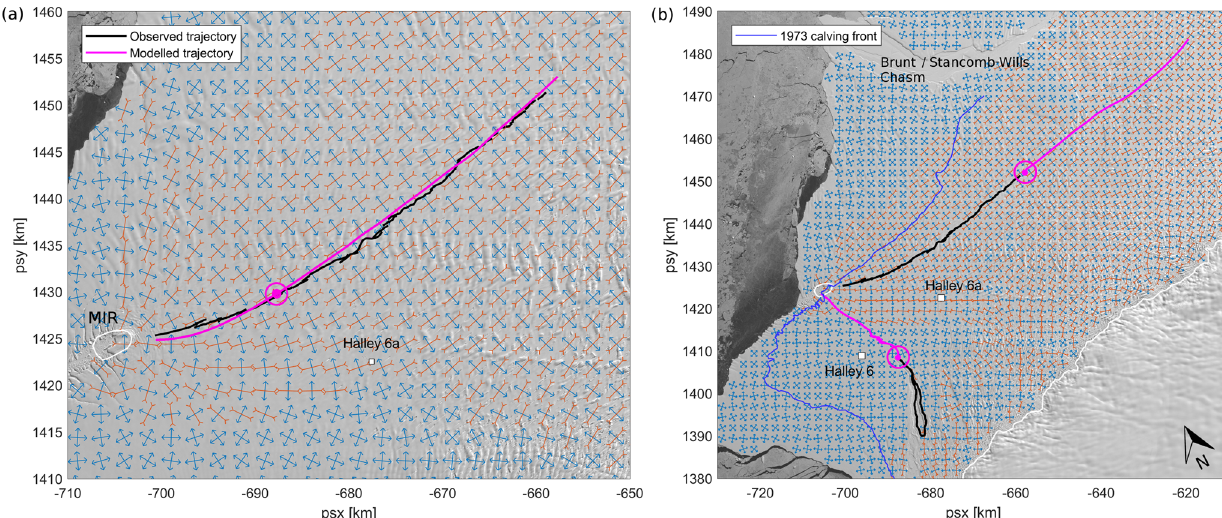
Figure 8. (a) Modelled principal stress components (red are compressive, blue are extensive) in June 2015, resampled on a regular 2.5km by 2.5km grid. The modelled trajectory of Halloween Crack based on the direction of maximal tensile stress is shown in magenta; the observed trajectory from 15 March 2017 is plotted in black. (b) Modelled principal stress components in March 2017 and predicted future trajectories of Chasm 1 and Halloween Crack. The purple line corresponds to the 1973 calving